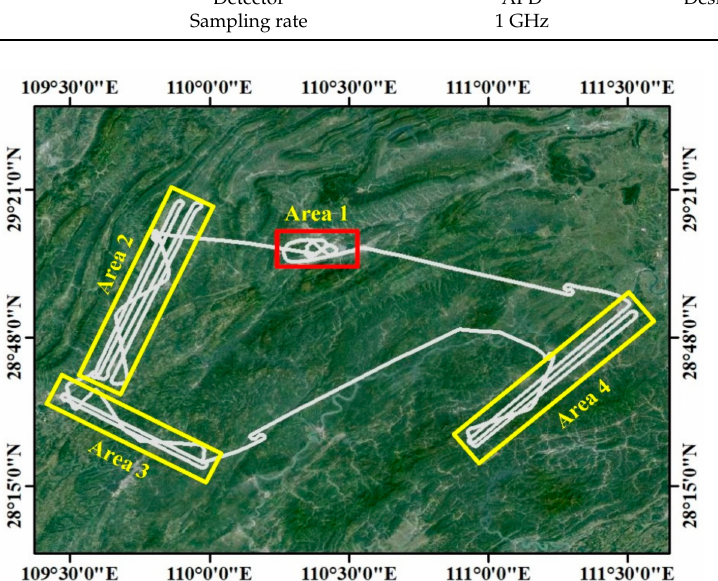
Figure 1. Map of airborne large-footprint lidar measurement areas used in this study. Area 1 was used to verify the elevation accuracy, whereas Areas 2–4 were used to verify the plane